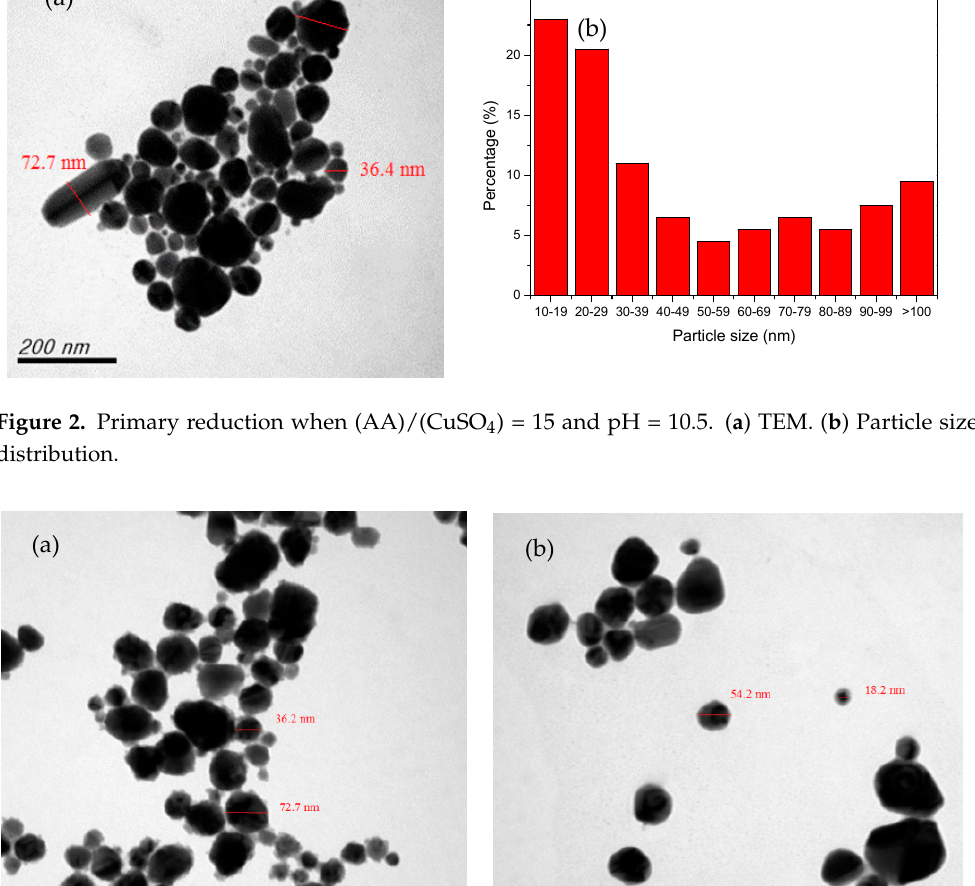
Figure 5. TEM of secondary reduction: ( a ) (AA)/(CuSO 4 ) = 10; ( b ) (AA)/(CuSO 4 ) = 15. 3.1.2. Effect of Reaction Temperature